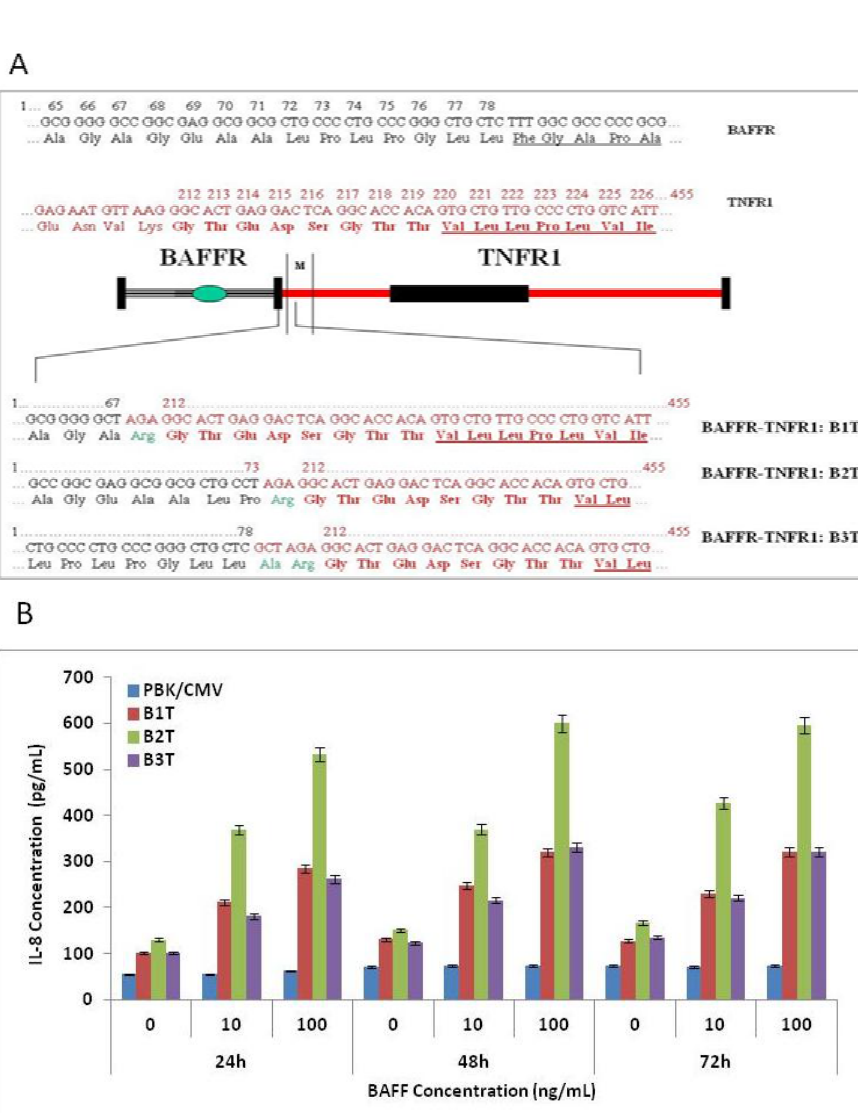
Figure 1. ( A ) Schematic fusion site structure of BAFFR and TNFR1 hybrid receptor constructs. The extracellular domain of the human BAFF receptor (BAFFR) is fused to the transmembrane and cytoplasmic domain of human TNF receptor 1 (TNFR1). The cysteine rich domain (CRD) of BAFFR and the death domain of TNFR1 are marked. Nucleotide and amino acid sequences of the fusion site at the outside border of the transmembrane region are shown in detail (BAFFR sequence in black, TNFR1 sequence in red, transmembrane domain sequences of each receptor underlined). Amino acids in bold red represent the TNFR1 sequence that was contained in all hybrid receptors. The cloning strategy resulted in two conserved amino acid changes (shown in green) at the last position of BAFFR sequence, i.e. , Lys to Arg, Val to Ala. ( B ). The response of transiently transfected cells to BAFF stimulation. Cells transfected with pBK/CMV (blue), B1T (red), B2T (green) and B3T (purple) constructs were incubated with 0, 10 and 100 ng/mL of BAFF after 24, 48 and 72 h of transfection. IL-8 levels in the culture supernatants were measured by IL-8